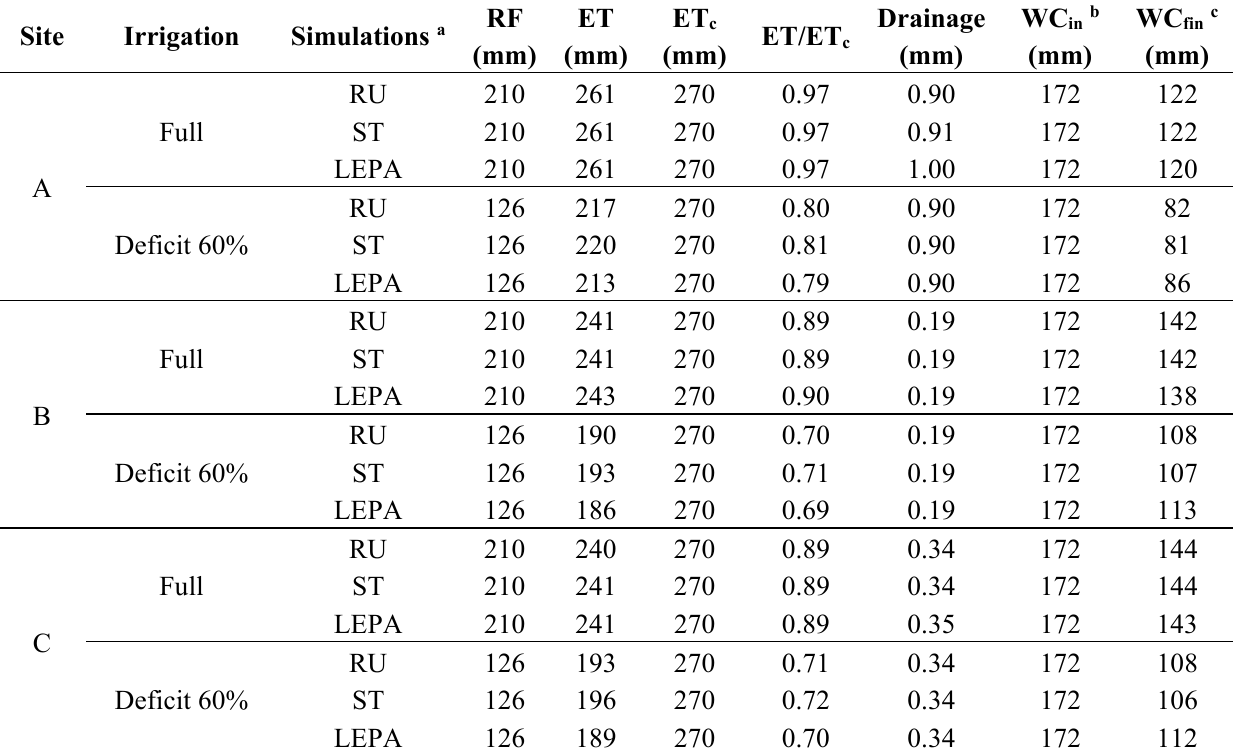
Table 2. Water mass balance estimated for two different irrigation management